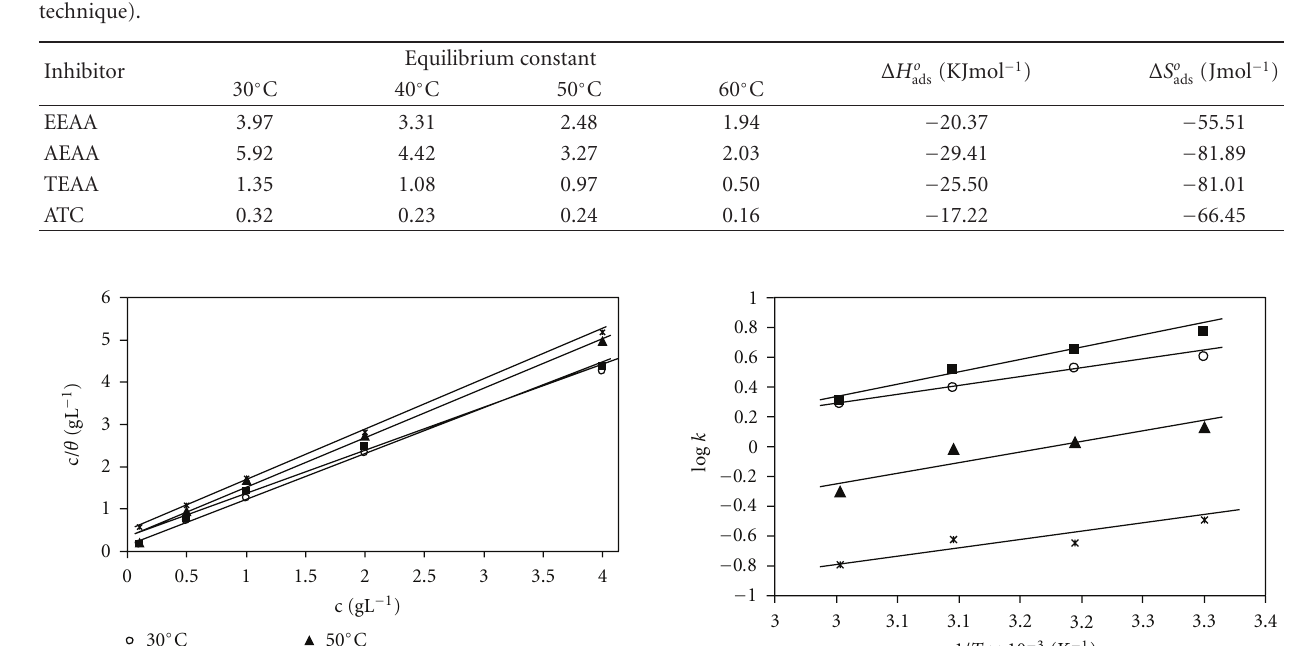
Table 4: Thermodynamic parameters for the adsorption of EEAA, AEAA, TEAA, and ATS on mild steel in 5M H 2 SO 4 (using the gasometric technique).